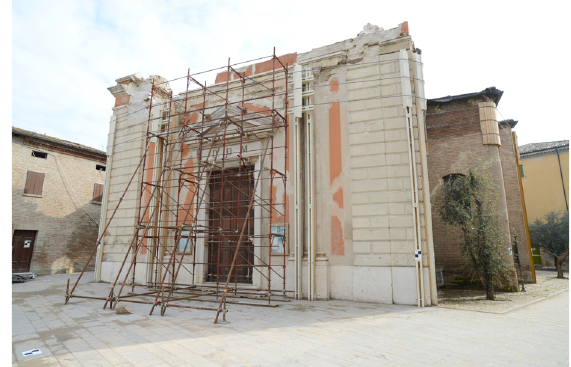
Figure 1: The church of San